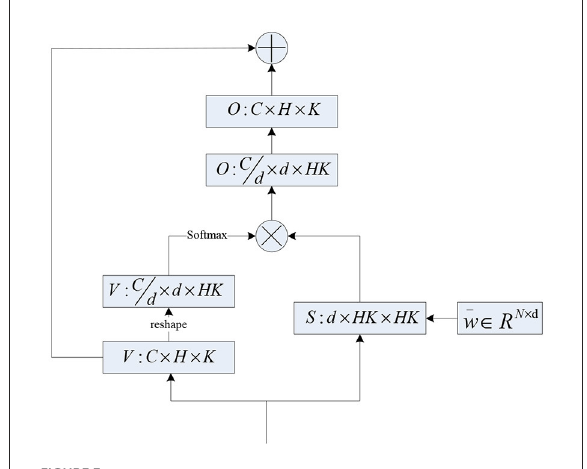
FIGURE3 The computation flowchart of proposed multi-head